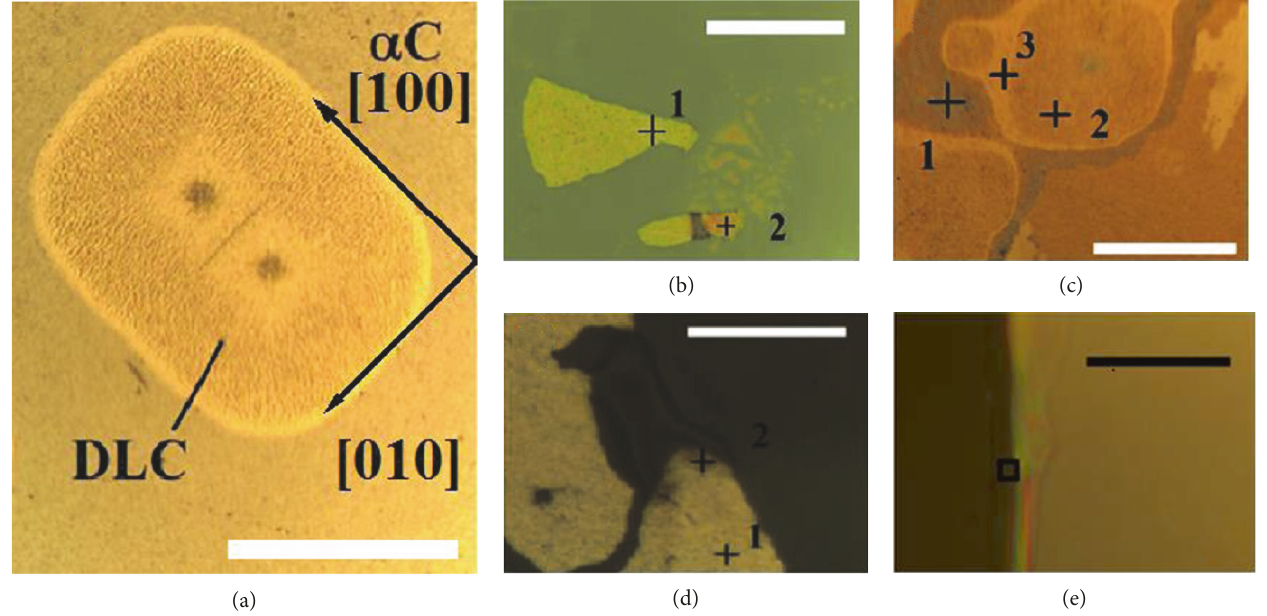
Figure 1: Optical microscopy image of the surface morphology of (a) as-deposited graphene and graphene-related phases on diamond-like carbon (DLC) and amorphous carbon ( α C) interlayers. The arrows remarked [100] and [010] directions of the Si substrate. The marker represents 20 μ m. (b) The exfoliated and transferred graphene fl akes on 320nm SiO . The Raman spectra are taken from “ + ” -marked 2 positions. The marker represents 30 μ m. (c) The layers remaining on the surface of the substrate after exfoliation by Scotch tape. The Raman spectra are taken from the “ + ” -marked positions near points 1, 2, and 3. The marker represents 30 μ m. (d) The exfoliated and transferred graphene fl akes on glass substrate. The Raman spectra are taken from the “ + ” -marked positions near points 1 and 2. The marker represents 20 μ m. (e) A graphene fl ake on air bubble near the epoxy resin surface. The Raman spectra are taken from the square- marked position. The marker represents 20 μ